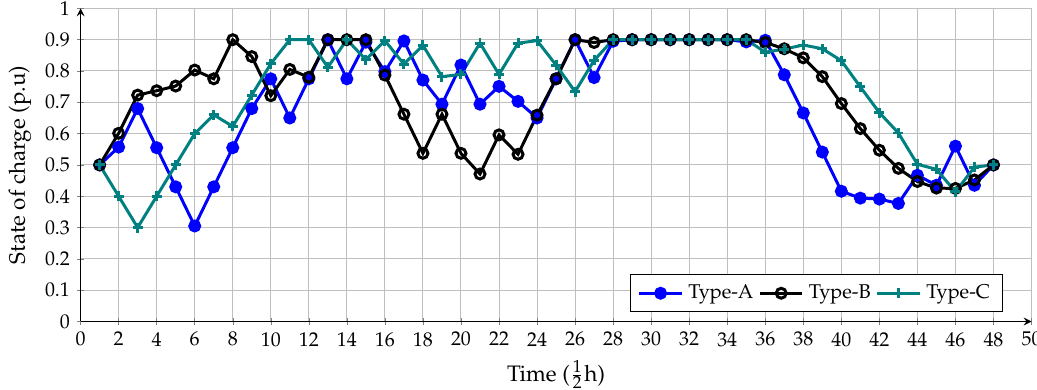
Figure 4. Behavior of the state of charge/discharge of batteries after solving the S 2 .